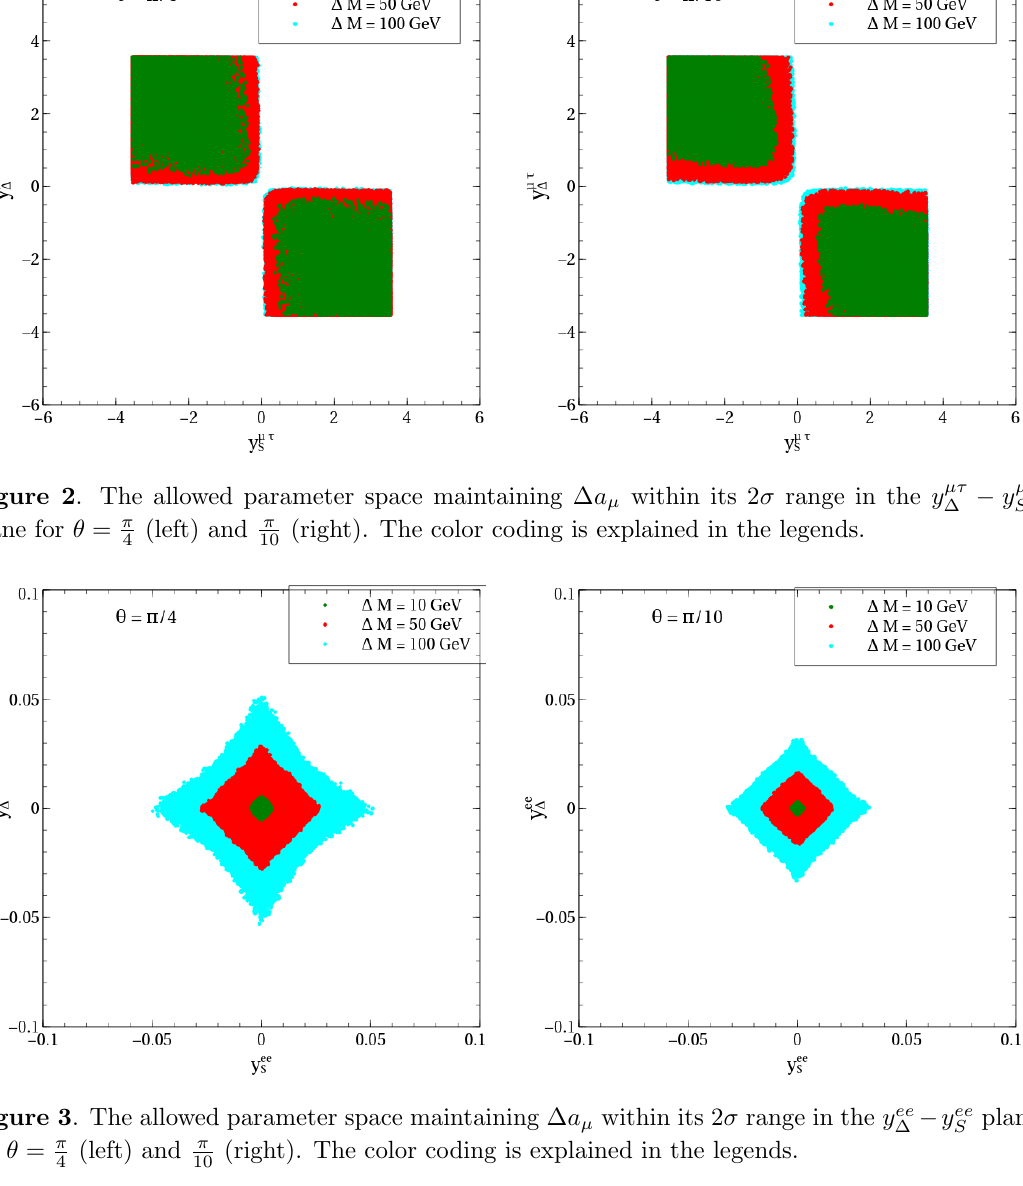
The same parameter points are plotted in the y (cid:22)(cid:28)